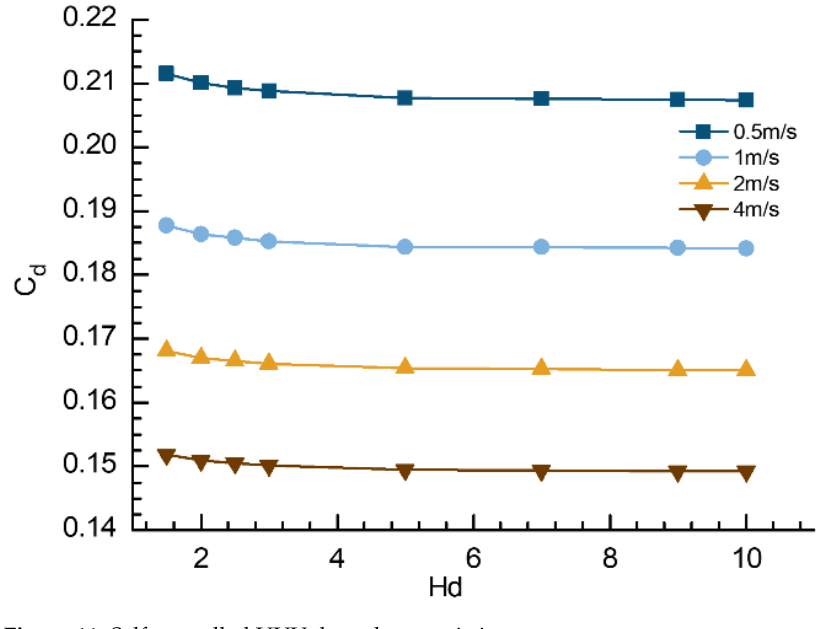
Figure 11. Self-propelled UUV drag characteristics.